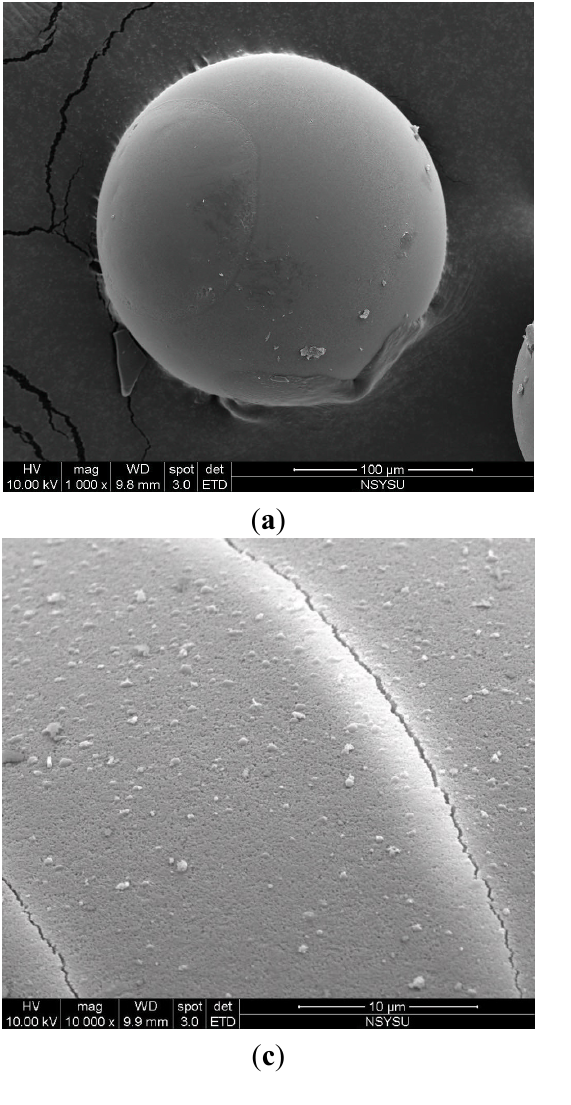
Figure 5. ESEM images showing the surface views of DVB particle before (( a ) and ( b